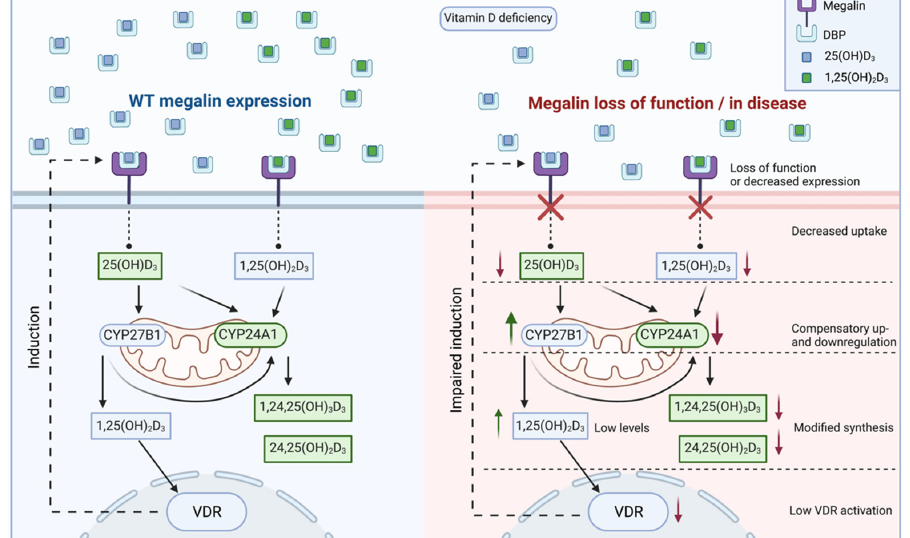
Figure 4 . Involvement of megalin in vitamin D metabolism and proposed effect of kidney disease or loss of function. After megalin-mediated endocytosis, 25-hydroxyvitamin D 3 (25(OH)D 3 ) may be sent to the mitochondria for cytochrome P450 (CYP)-mediated inactivation or CYP27B1-mediated activation. 1,25-dihydroxyvitamin D 3 (1,25(OH) 2 D 3 ), either endocytosed or intracellularly